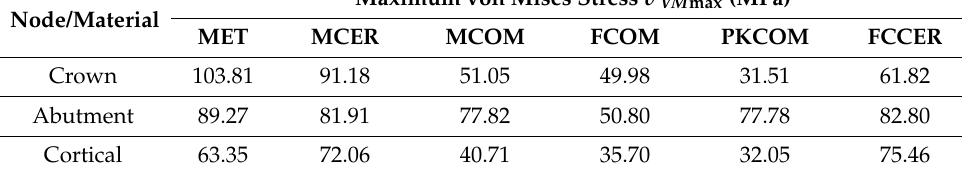
Figure 2. The nodes selected for numerical simulation. ( A ) Sectional view of the 3D FEA model at the crown node. ( B ) The abutment node. ( C ) The node on top of the cortical bone. Table 2. Maximum equivalent von Mises stress transferred to the crown, the titanium abutment, and the cortical bone by the different prosthesis materials.